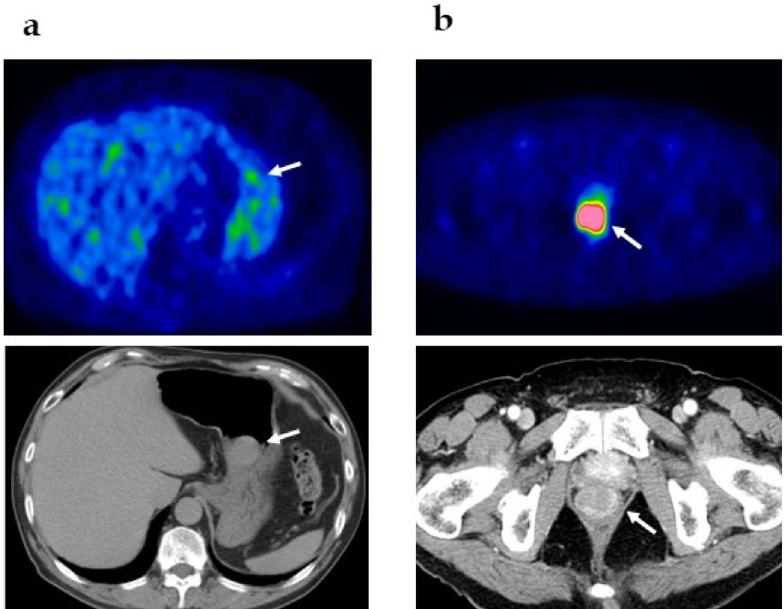
Figure 1. Representative cases. ( a ) Low-risk case in the stomach with a tumor size of 3.3 cm, mitosis 3/HPF, and SUVmax 4.58. ( b ) High-risk case in the rectum with a tumor size of 3.0 cm, mitosis 26/HPF, and SUVmax 20.68. Arrows indicate tumors.